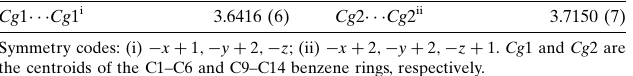
Data collection Bruker SMART APEXII CCD area-detector diffractometer Absorption correction: multi-scan ( SADABS ; Bruker, 2005)